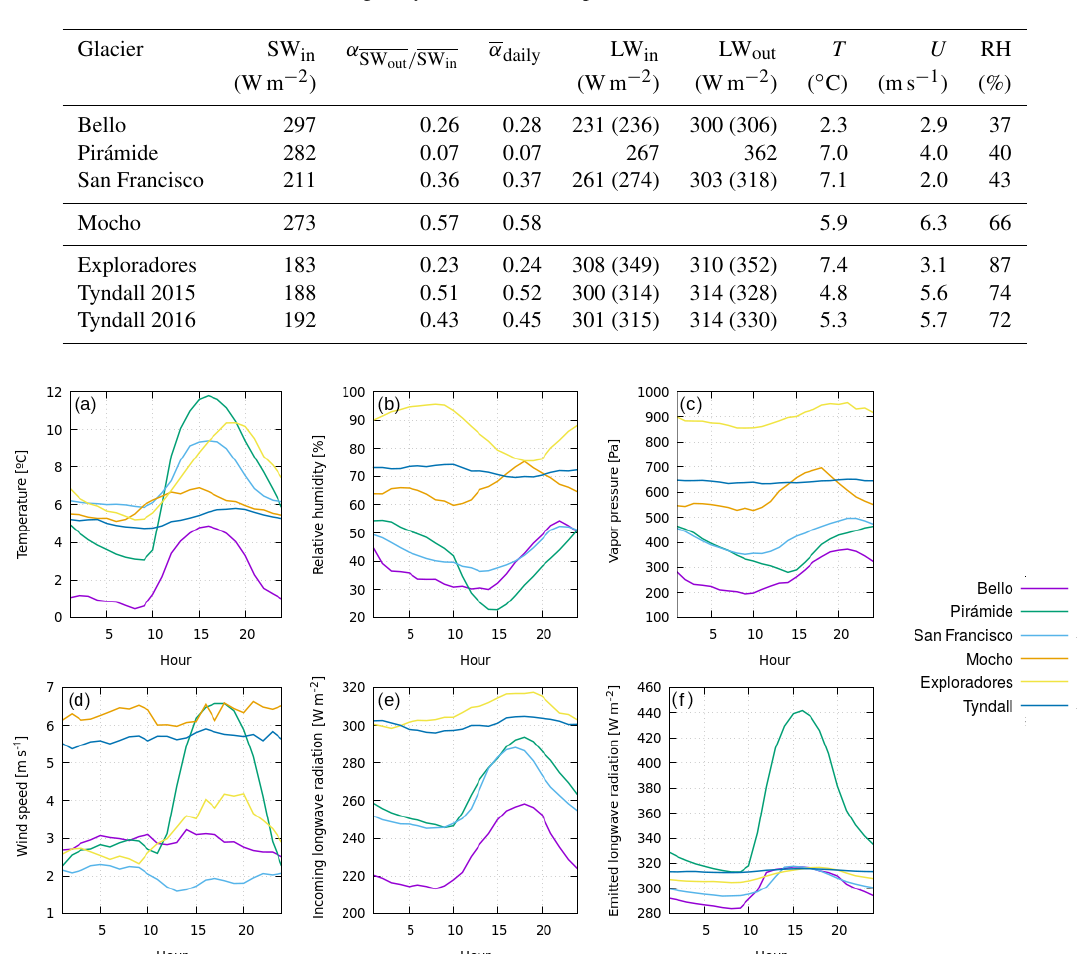
Figure 4. Averages of meteorological variables at the different hours of the day during the study periods on the six studied glaciers: (a) tem- perature T , (b) relative humidity RH, (c) water vapor pressure P vap , (d) wind velocity U , (e) incoming longwave radiation LW in , (f) outgoing longwave radiation LW out . Time is local